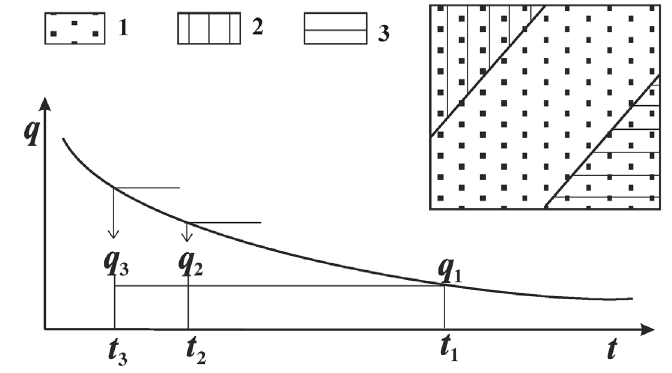
Fig. 6. Heat flow and thermal events in the earth crust. 1 – Crustal block formed by the impulse M 1 during the epoch t 1 ; 2 – its fragments re-activated by M 2 during t 2 ; 3 – by M 3 during t 3